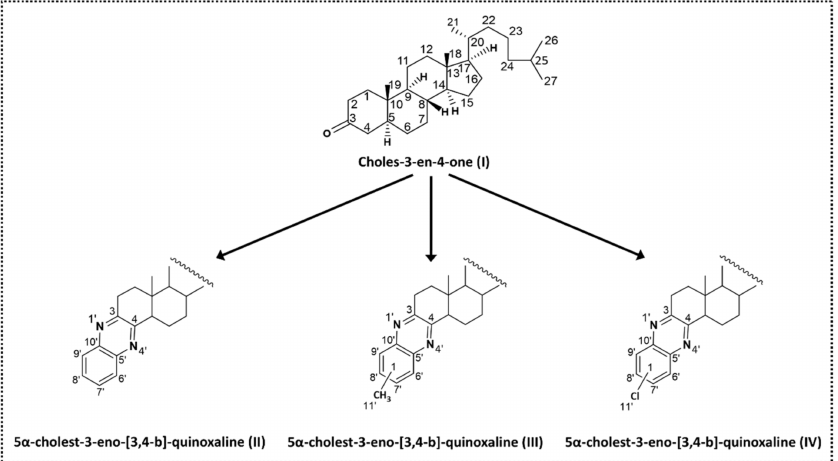
Figure 3. Structural representation of synthesised compounds along with the carbon and nitrogen atom